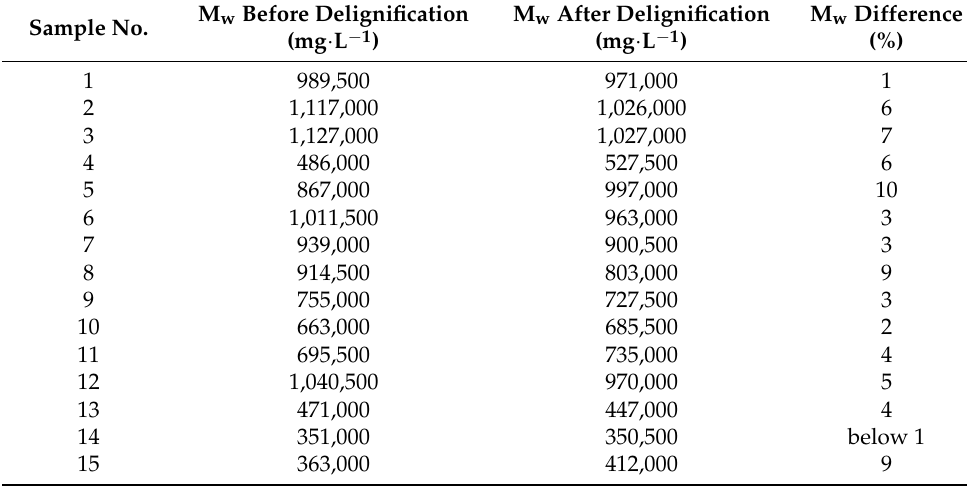
Table 4. Weight average molecular mass (M w ) for CTC derivatives of the samples before and after delignification. The measurements were performed in duplicates. Relative standard deviation for M w determinations was below